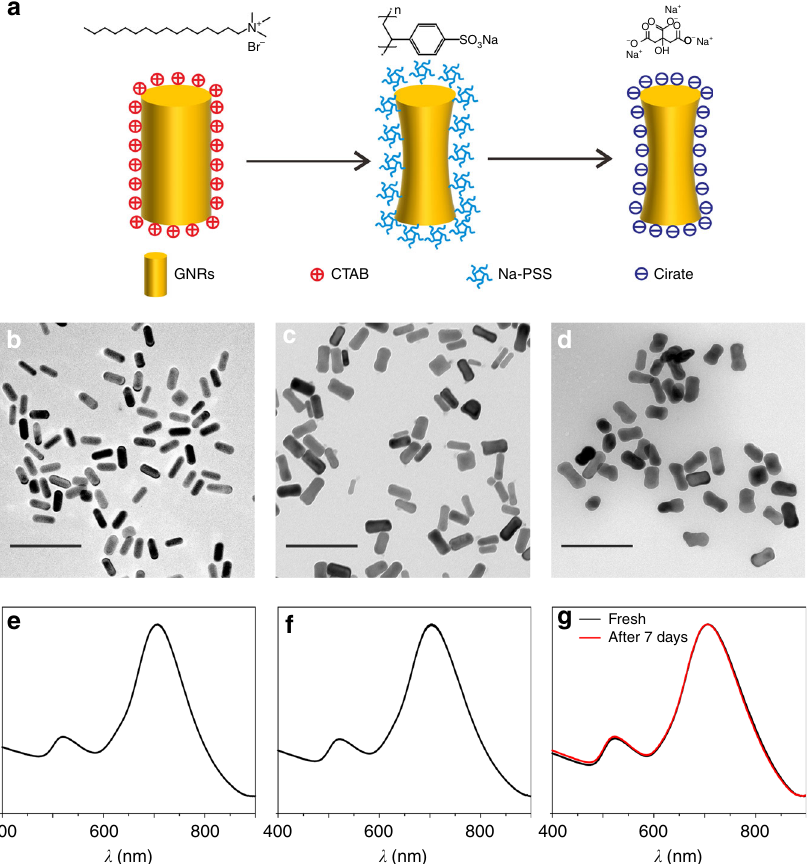
Fig. 2 GNR surface modi fi cation. a Schematic illustration of the PSS-mediated surface modi fi cation from CTAB to citrate. TEM observations and the corresponding UV – Vis absorbance spectra of the as-prepared Ct-GNR sols ( b , e ), Pss-GNRs sols ( c , f ), and Ci-GNR sols ( d , g ). A UV – Vis spectrum of the Ci-GNR sols aged for 1 week (red line) was overlapped in g for contrast. All of the scale bars are 200